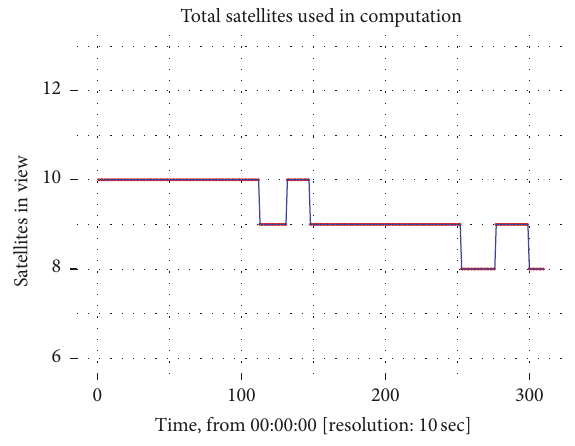
Figure 15: Number of satellites used in the computation. Baseline of ∼ 41km, year: 2014, DOY: 85. Plotted as red dots connected by blue